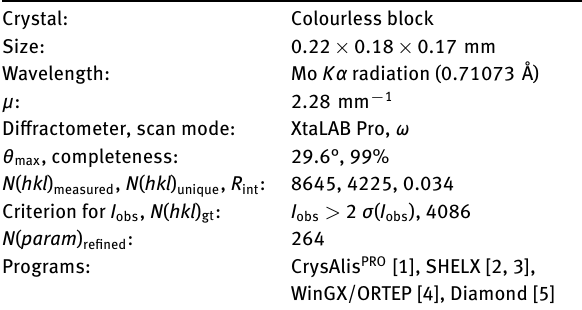
Source of material The AgNO 3